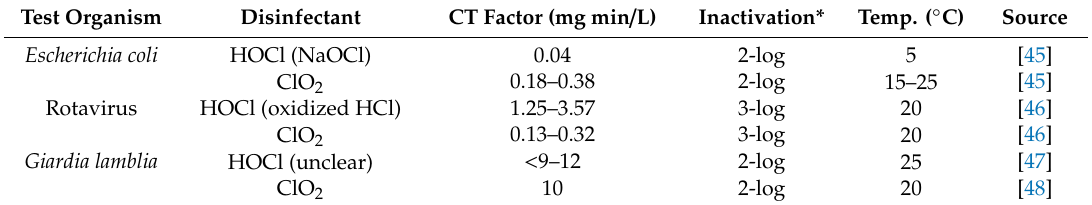
Table 4. CT-factors (concentration × time) from the literature for free chlorine and ClO 2 against selected test